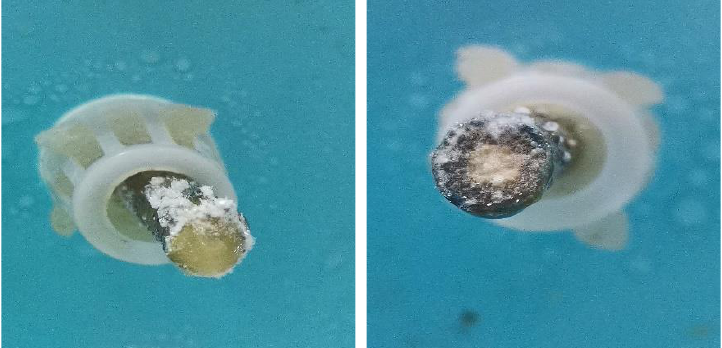
Figure 6. Mulberry cuttings with mildew disease.